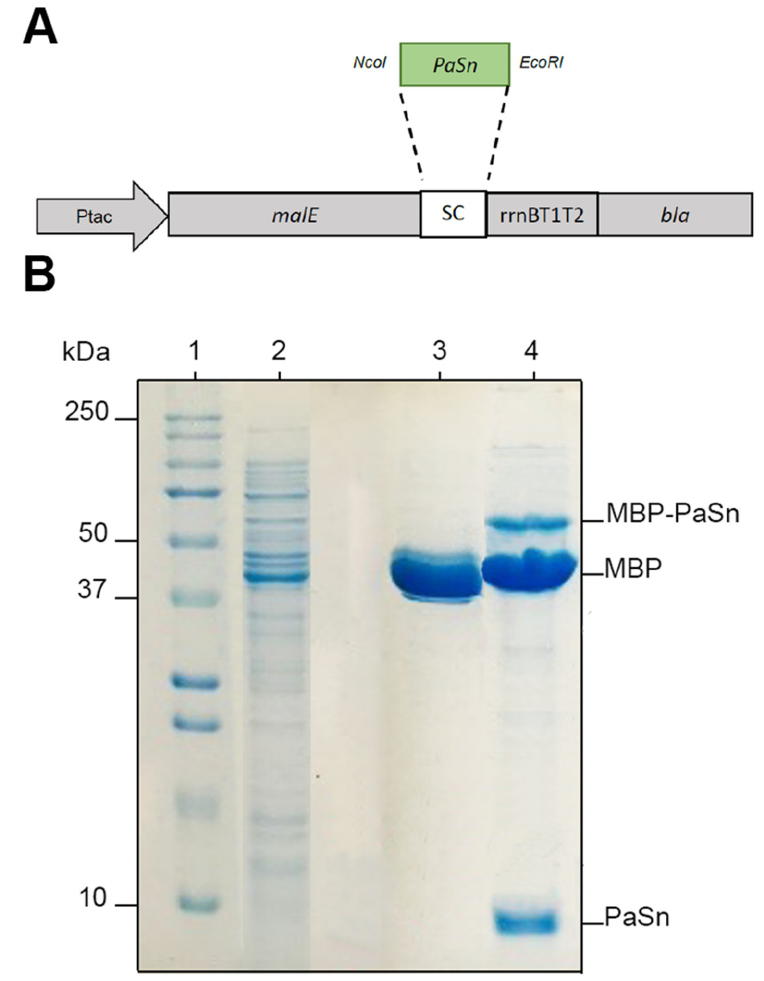
Figure 1. ( A ) Map of the construct pMALc5x-PaSn vector expression. ( B ) SDS-PAGE analysis of purified recombinant PaSn. Soluble proteins of different purification steps. Lane 1, low-molecular- weight marker. Lane 2, total bacterial proteins. Lane 3, proteins after affinity column. Lane 4, proteins after Factor Xa digestion.